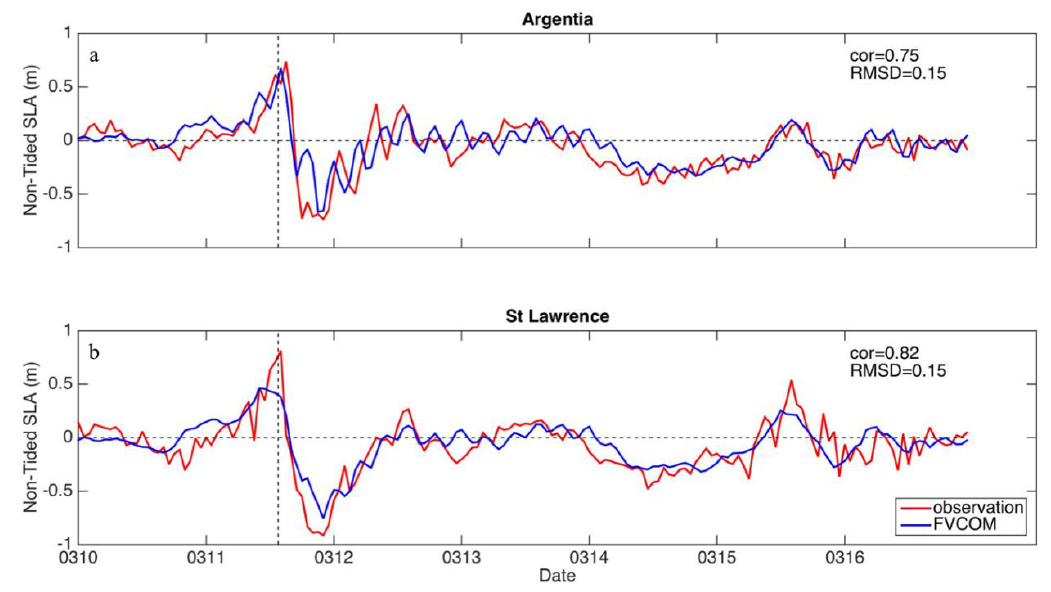
Figure 6. Time series of hourly non-tidal sea level anomalies (m) from tide-gauge observations (red) and model results (blue) at AG ( a ) and SL ( b ). The horizontal black dashed lines denote non-tide SLA = 0 m. The vertical black dashed lines denote the time of landfall.